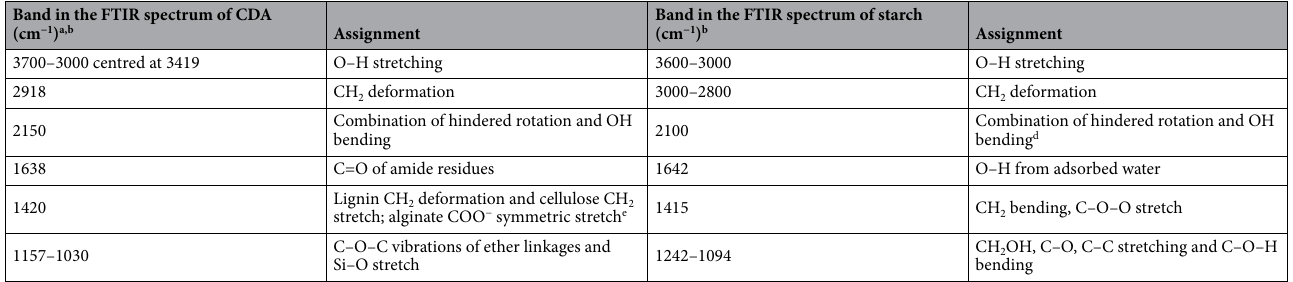
Table 1. Band assignments a,b for the FTIR spectra of CDA a and starch c . a Data from this work. b The AIST Spectral Database for Organic Compounds facilitated FTIR peak assignments, in addition to other literature sources cited. c Data taken from ref. 38. d See Ref. 40 . e Alginate was used in the preparation of CDA matrix (see caption to Fig. 1A).